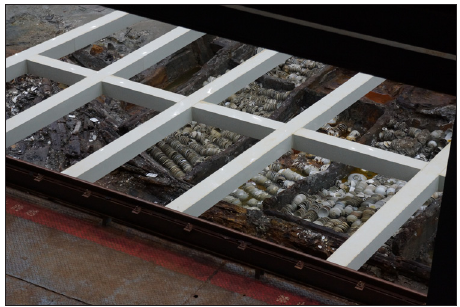
Figure 4: The late 12 th century Nanhai No